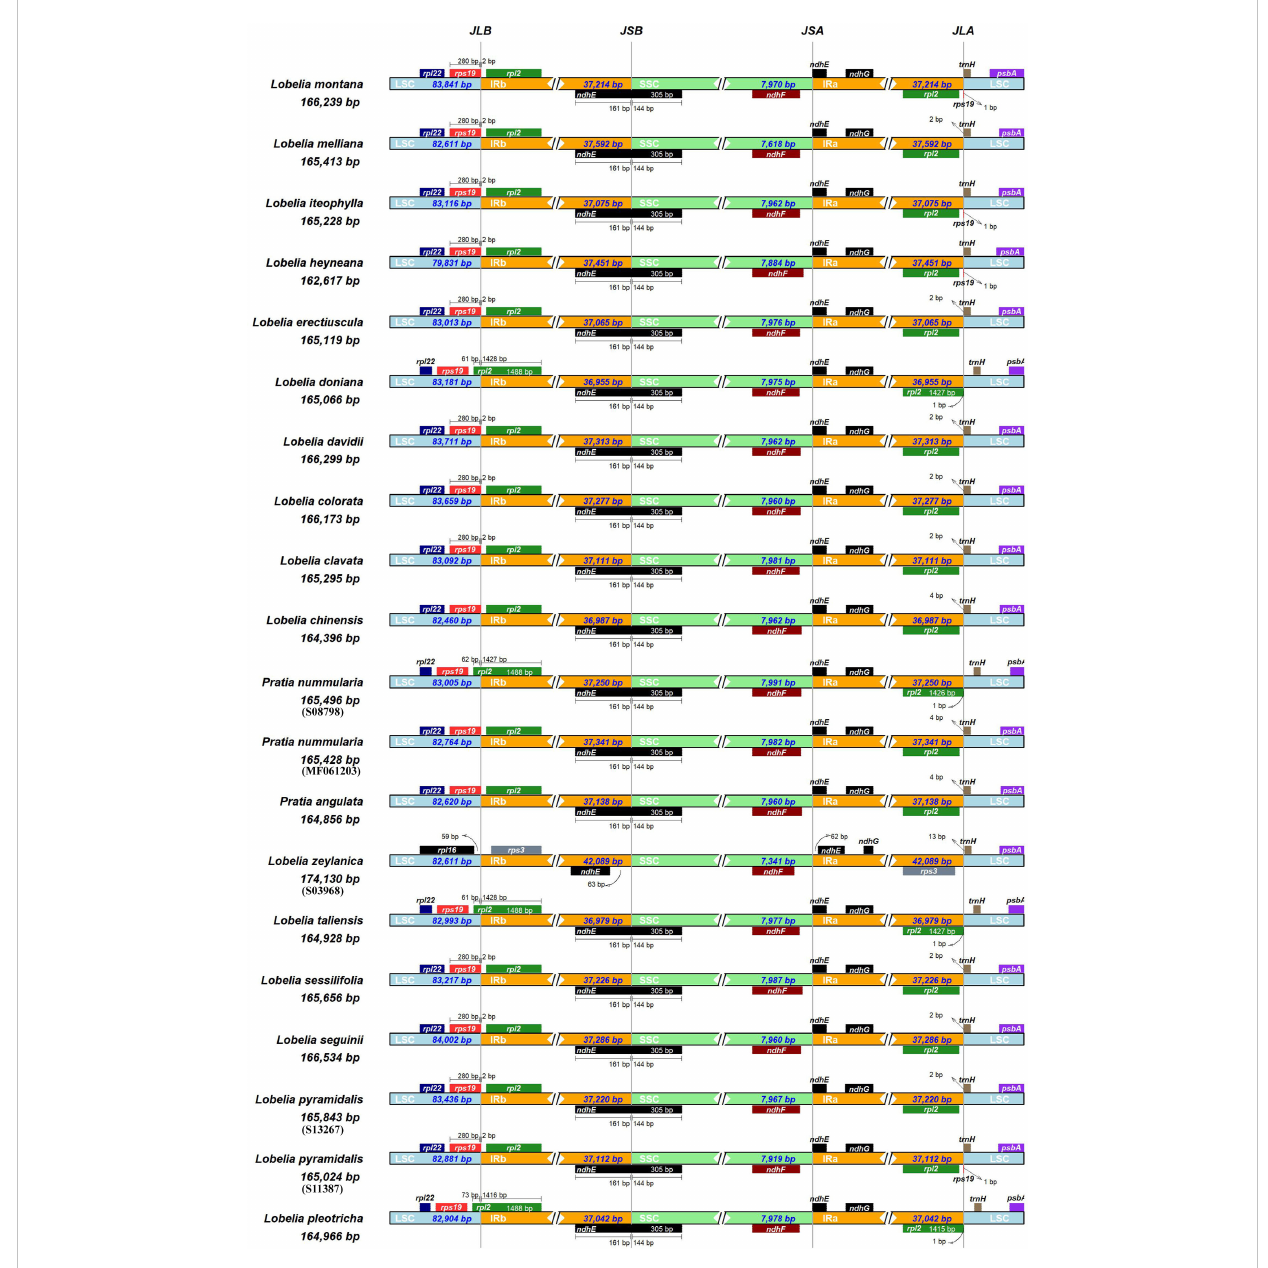
FIGURE 2 Comparison of IR-SC border positions across plastomes of twenty East Asian lobelias. Genes are denoted by colored boxes. The gaps between the genes and the boundaries are indicated by the base lengths